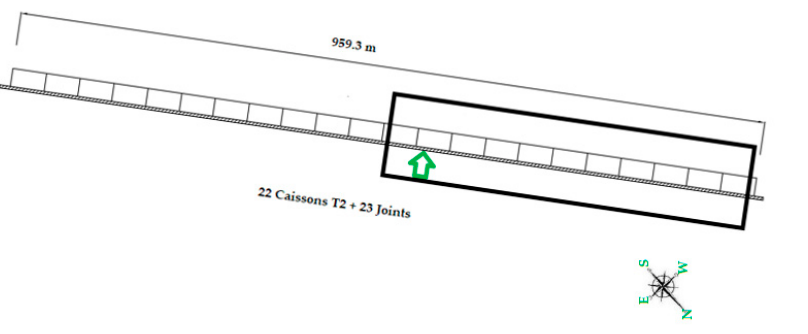
Figure 5. Location of the test area where the DP-SACI was